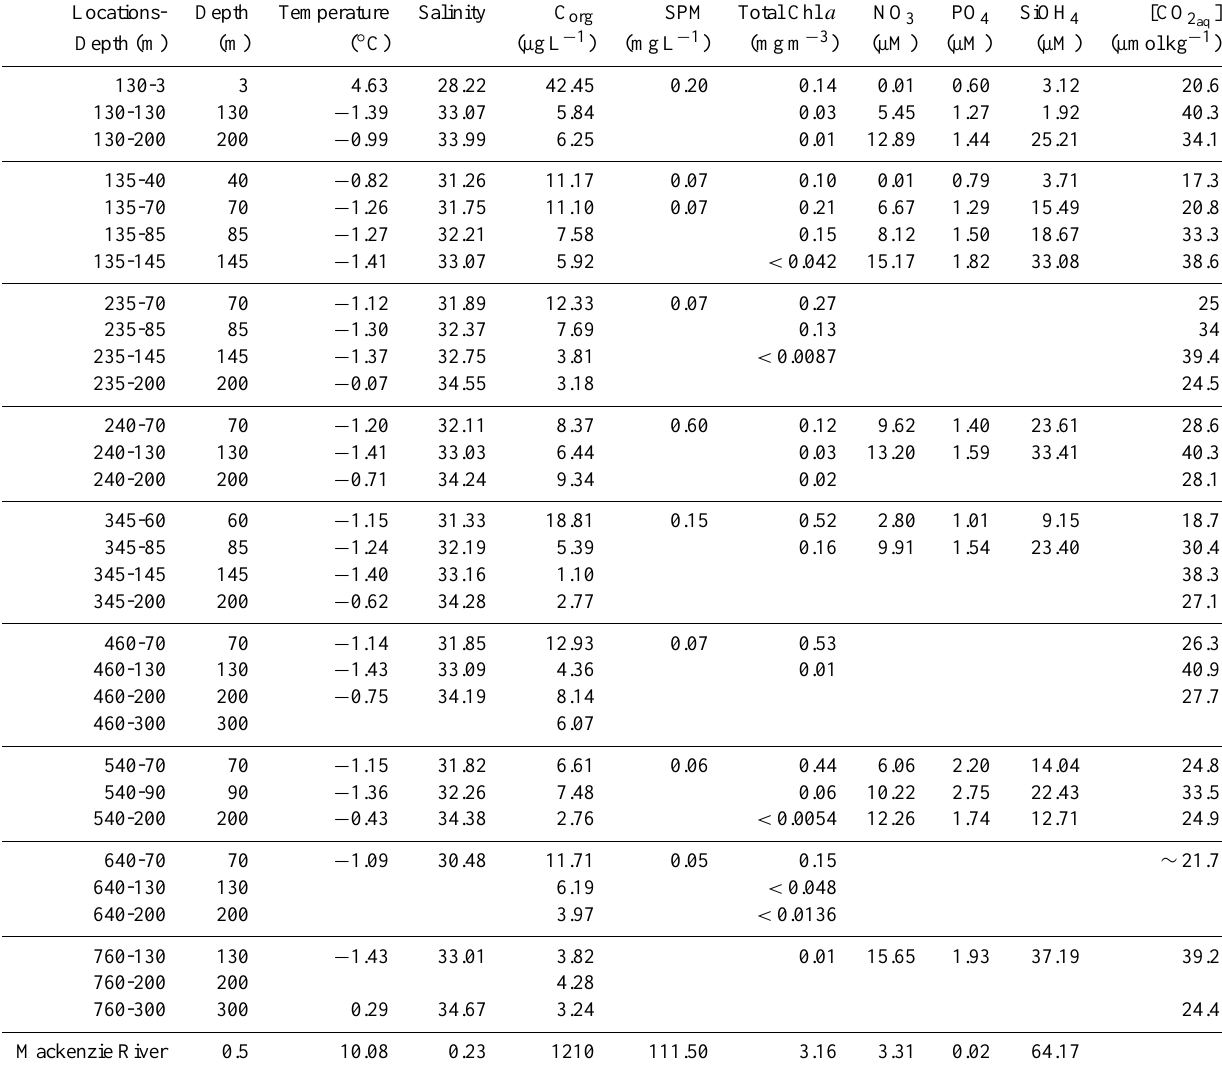
Table 2. Bulk biochemical parameters corresponding to the suspended particulate matter (SPM) samples in the Beaufort Sea and Mackenzie River. Stations are identified by their number (e.g. 130) followed by the sampling depth (e.g. 3).